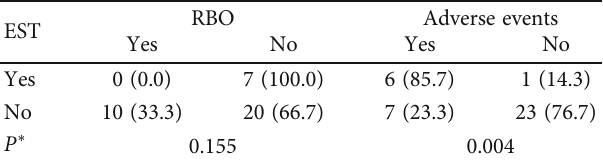
Table 5: E ff ect of EST on RBO and adverse events. EST